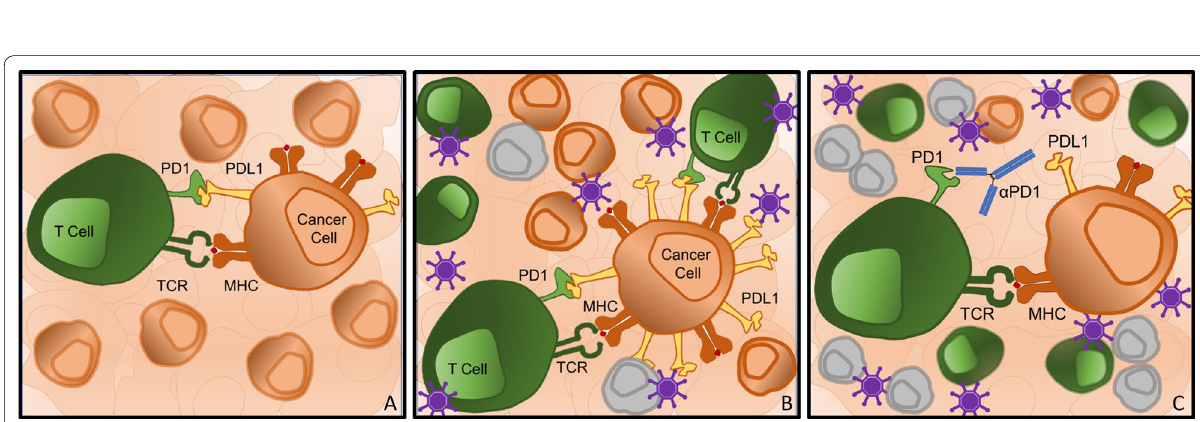
Fig. 2 Combining oncolytic vectors and checkpoint inhibitors. A Illustration of the PD-1/PD-L1 axis between a T cell and cancer cell, which suppresses T cell activation. B Oncolytic viruses have the ability to directly lyse and kill cancer cells (grey cells), but also can exert a change in the local tumor microenvironment by increasing immune cell activation and PD-L1 expression on cancer cells. C Following priming by an oncolytic virus infection and transition to a ‘hot’ tumor microenvironment, checkpoint inhibitors (anti-PD-1 antibody) are more efficacious at decreasing T